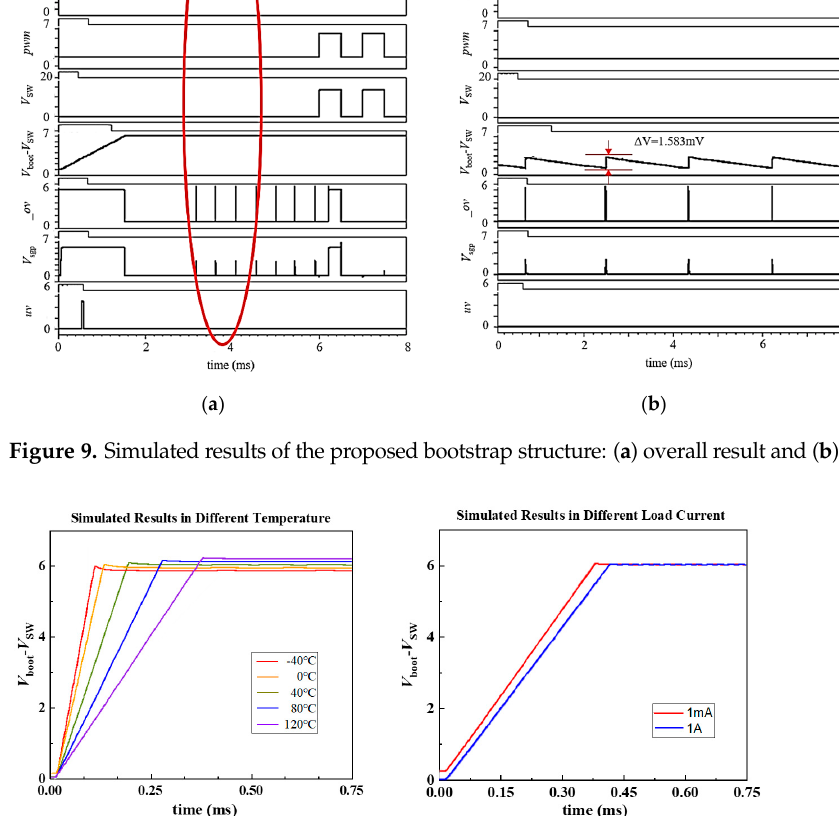
Figure 9. Simulated results of the proposed bootstrap structure: ( a ) overall result and ( b ) enlarged result.